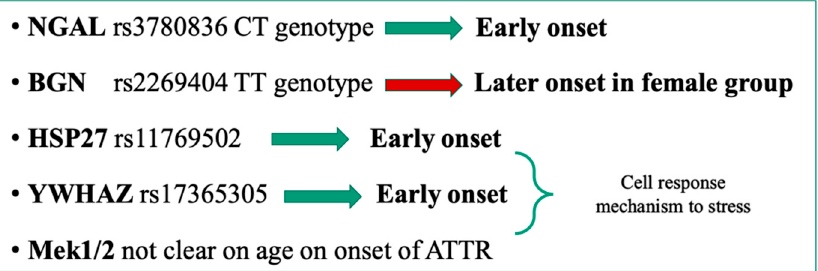
Figure 1. Genes and their SNPs involved in the genetic modulation of hATTR disease. The main gene, TTR , responsible for disease severity could be modulated by the presence/absence of specific alleles in the indicated genes. Data from [30].